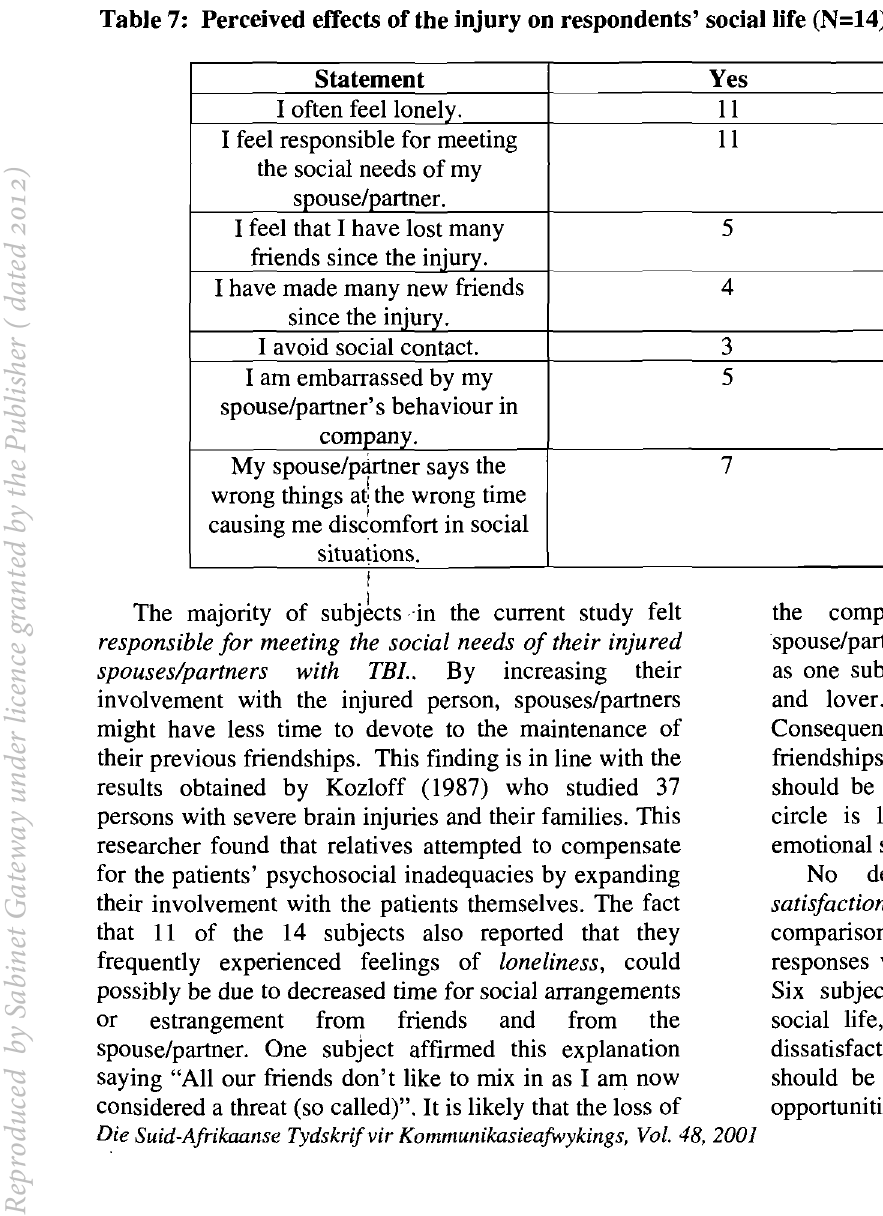
TabJe 7: Perceived effects of the injury on respondents' sociaJ life